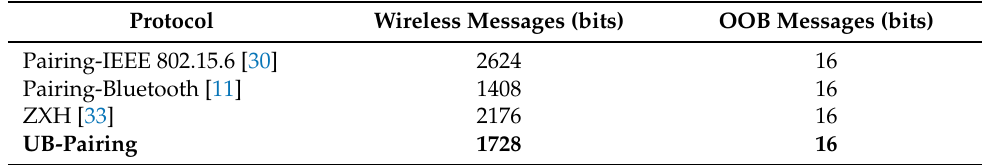
Table 6. Communication costs under curve